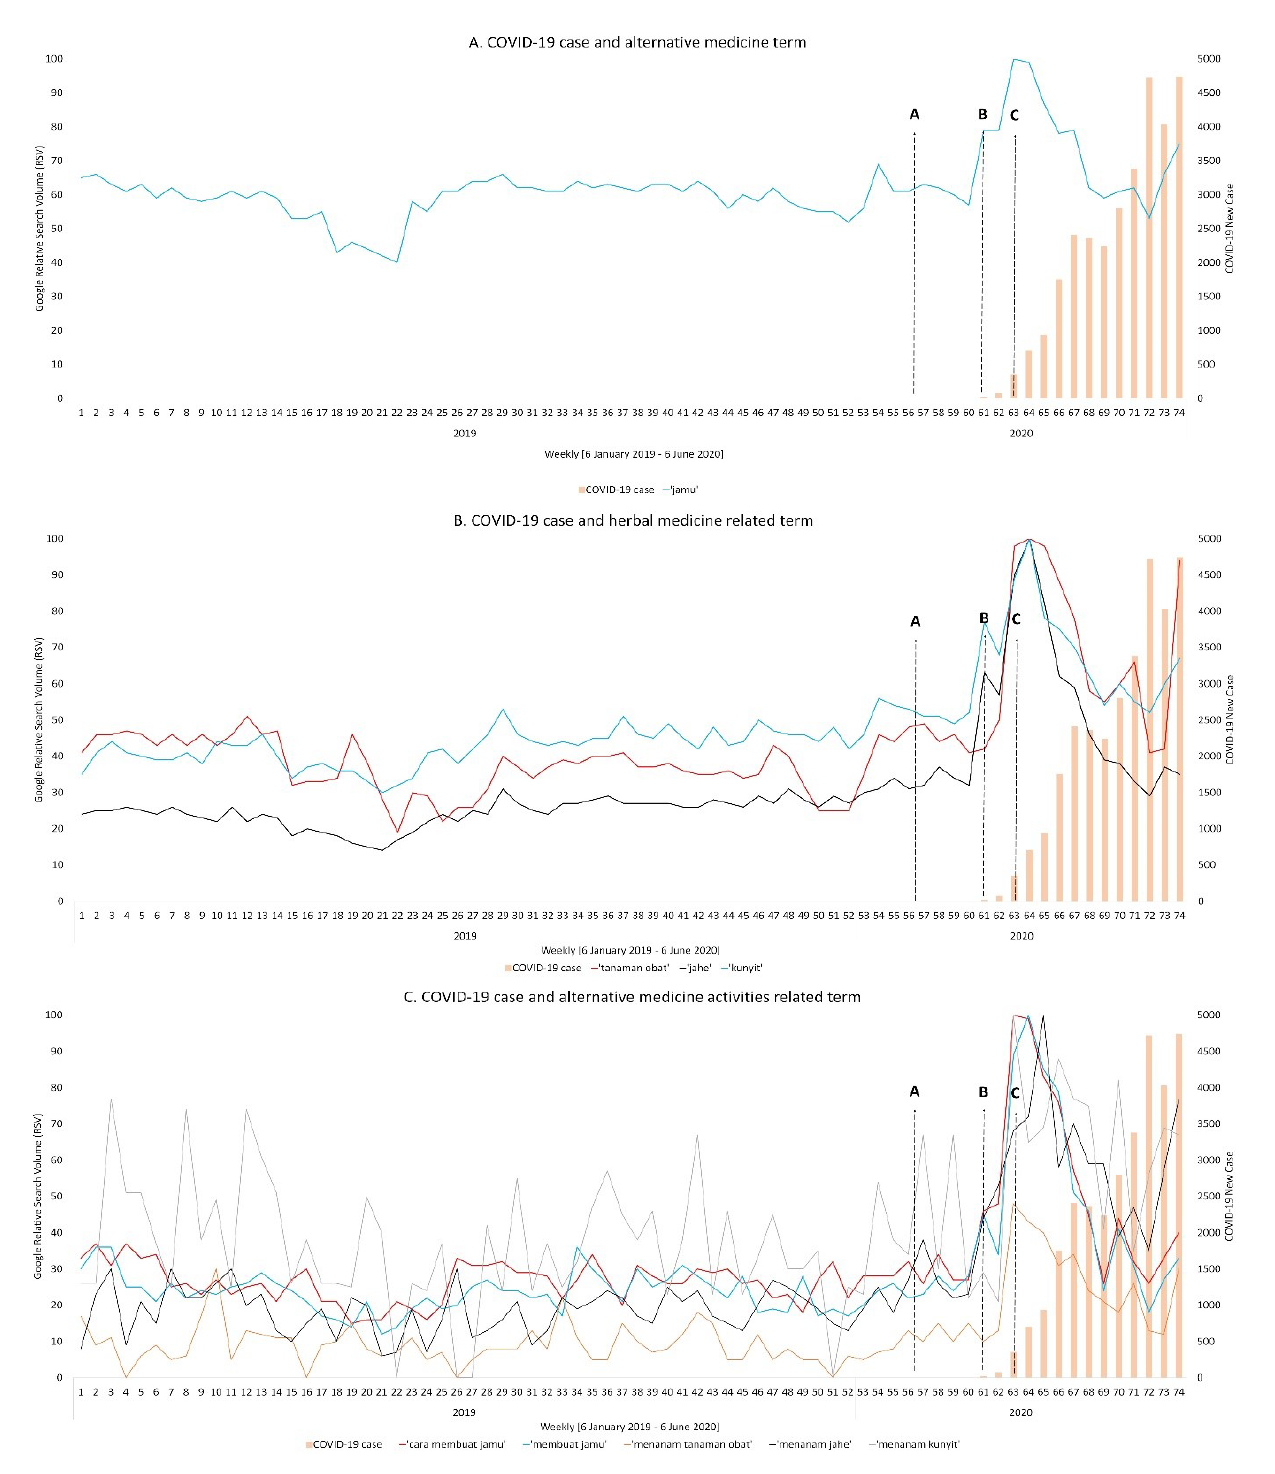
Figure 1. Google Relative Search Volume and COVID-19 new cases in Indonesia. COVID-19 cases compared with ( A ) ‘ Jamu’ [alternative medicine] search term; ( B ) herbal medicine search terms (‘ tanaman obat ’ [herbal medicine], ‘ jahe ’ [ginger], ‘kunyit’ [curcumin]); ( C ) alternative medicine activities search terms (‘ cara membuat jamu ’ [how to make jamu], ‘ membuat jamu ’ [make jamu], ‘ menanam tanaman obat ’ [planting herbal medicines], ‘ menanam jahe ’ [planting ginger], and ‘ menanam kunyit ’ [planting curcumin]). Letters: A,